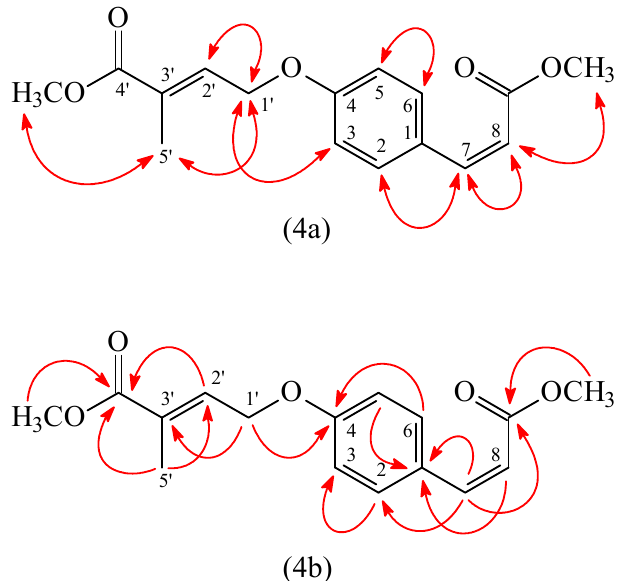
Figure 4. Key NOESY ( 4a ) and HMBC ( 4b ) correlations of 3